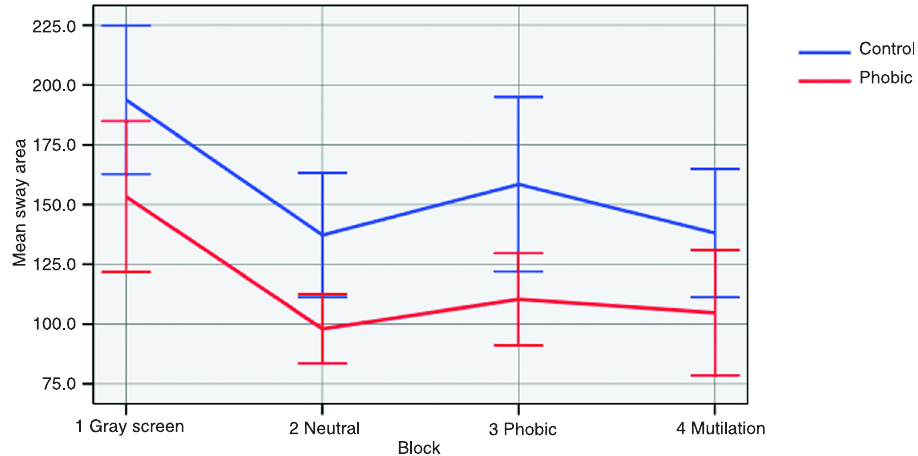
Figure 1. The means (95%CI) of the oscillation tend to stay close, possibly to habituation to the stimuli. In the anxiogenic block, a more specific stimulus, they are apart and then become closer again in the negative